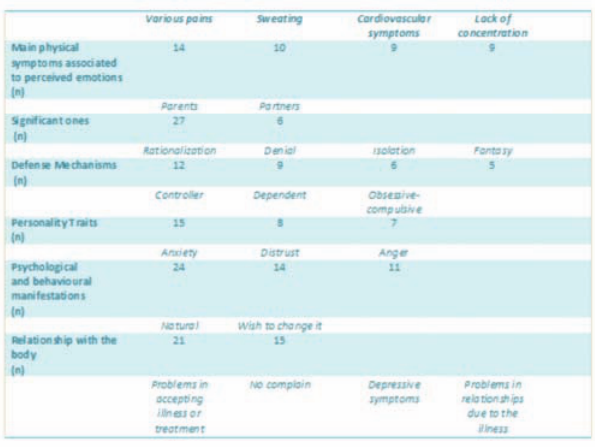
Table 2. Main events identified during pilot implementation - part 1.